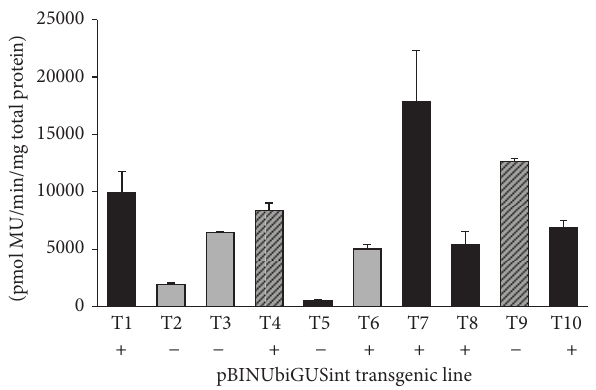
Figure 2: Fluorometric assay of 10 kanamycin-resistant lines. Different bar fills indicate transgene copy number: 1 copy (solid black), 2 copies (striped grey), and 3 or more copies (solid grey). The presence (+) or absence ( − ) of maturation is depicted under each transgenic